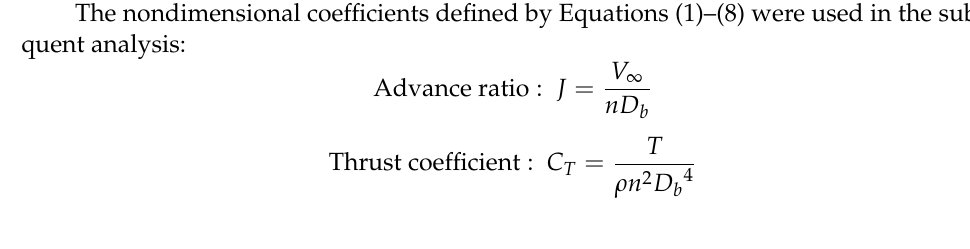
Figure 3. Coordinate system, showing positive sense of velocity, angle of attack, forces, and mo- ments. The nondimensional coefficients defined by Equations (1)–(8) were used in the sub- sequent analysis: